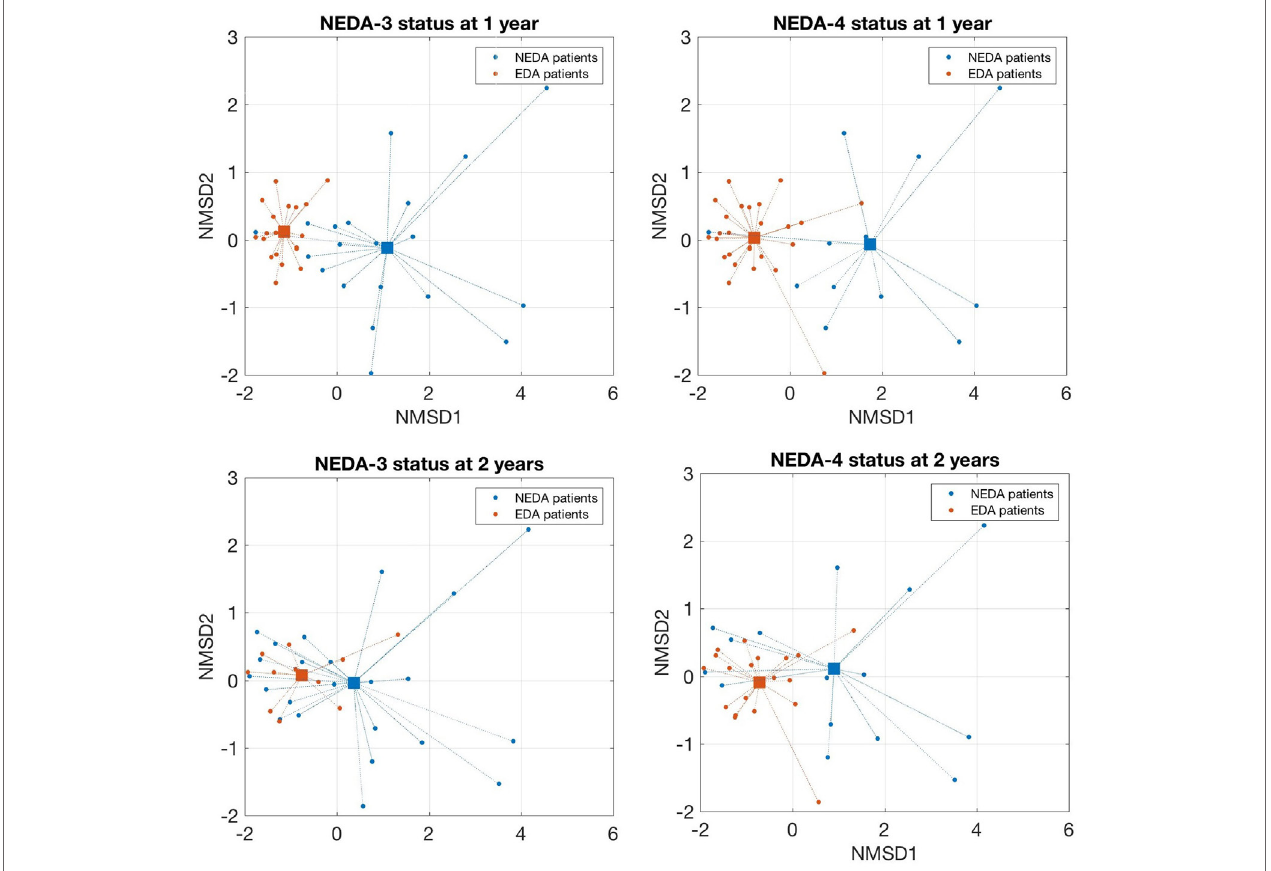
FigUre 3 | Nonparametric multidimensional scaling of selected lymphocytes subpopulations that discriminates responders and non-responder patients. A 2D representation by nonparametric multidimensional scaling (Seuclidean method) of the percentages of four selected lymphocyte subpopulations measured before treatment [natural killer (NK) bright, NK dim, plasmablasts, and IL-2-producing cells]. Individual patients and distance from the average of each condition are shown. Patients with a good response to fingolimod at 1 year (NEDA-3 and NEDA-4) were located in a well-differentiated region of space when the subpopulations are measured before treatment. At 2 years, this differentiation was less